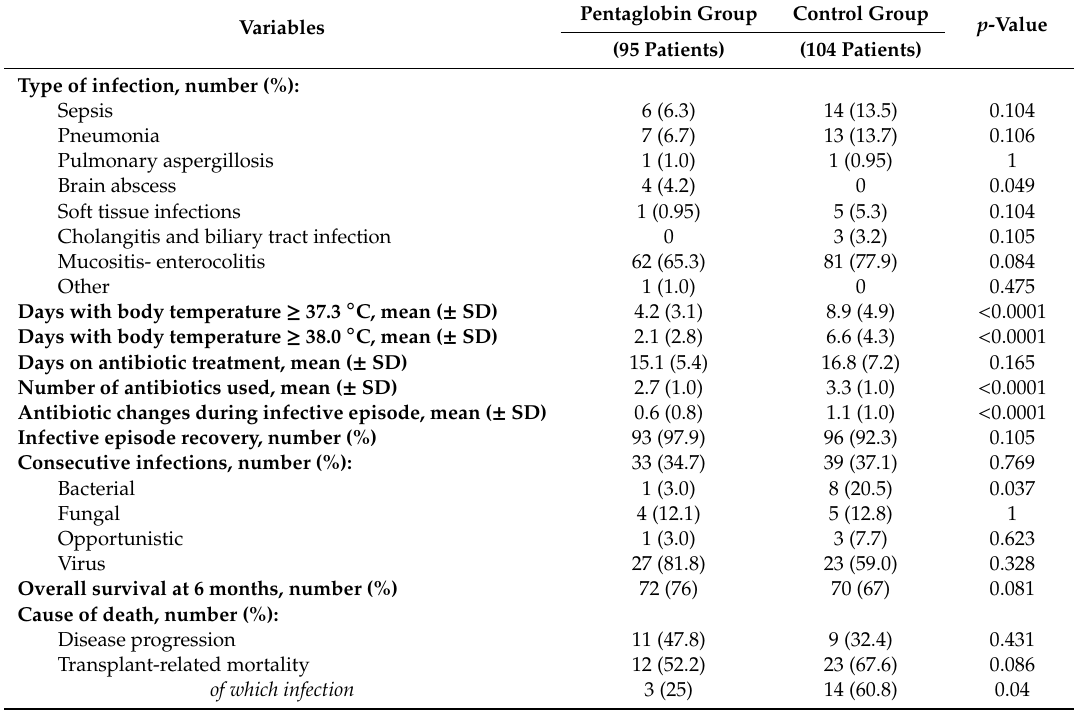
Table 2. Transplant-related outcomes. p -values refer to two-tailed Fisher exact tests if relative to 2 × n contingency tables, or to Mann–Whitney rank sum test if comparing values of continuous variables between two